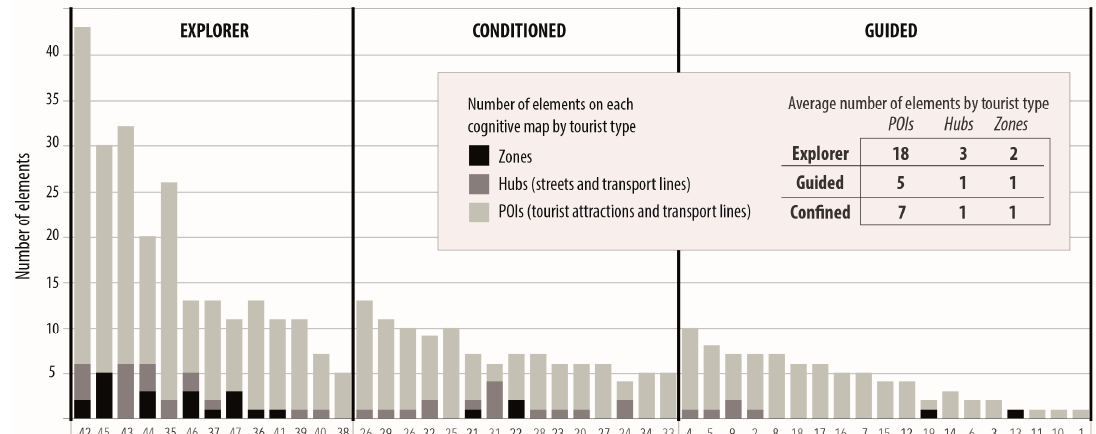
Figure 8. Number of POIs, hubs, and zones in the sketch of each tourist, by tourist type. ISPRS Int. J. Geo-Inf. 2018 , 7 , x FOR PEER REVIEW